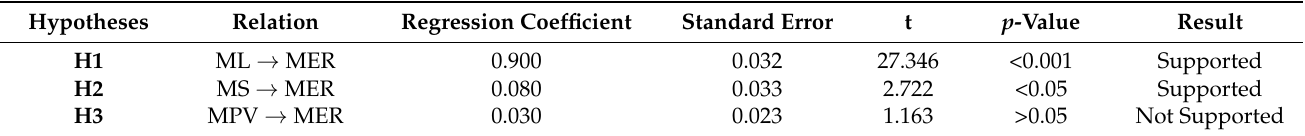
Table 2. Research hypotheses and statistical